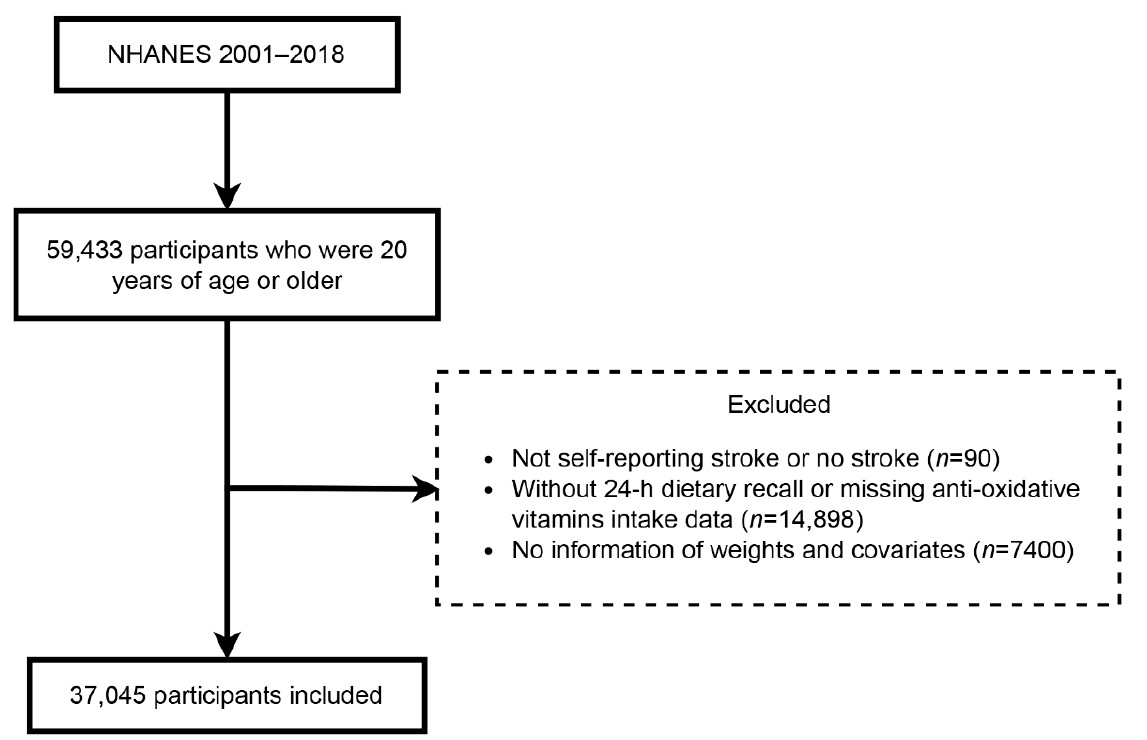
Figure 1. Flowchart for the selection of